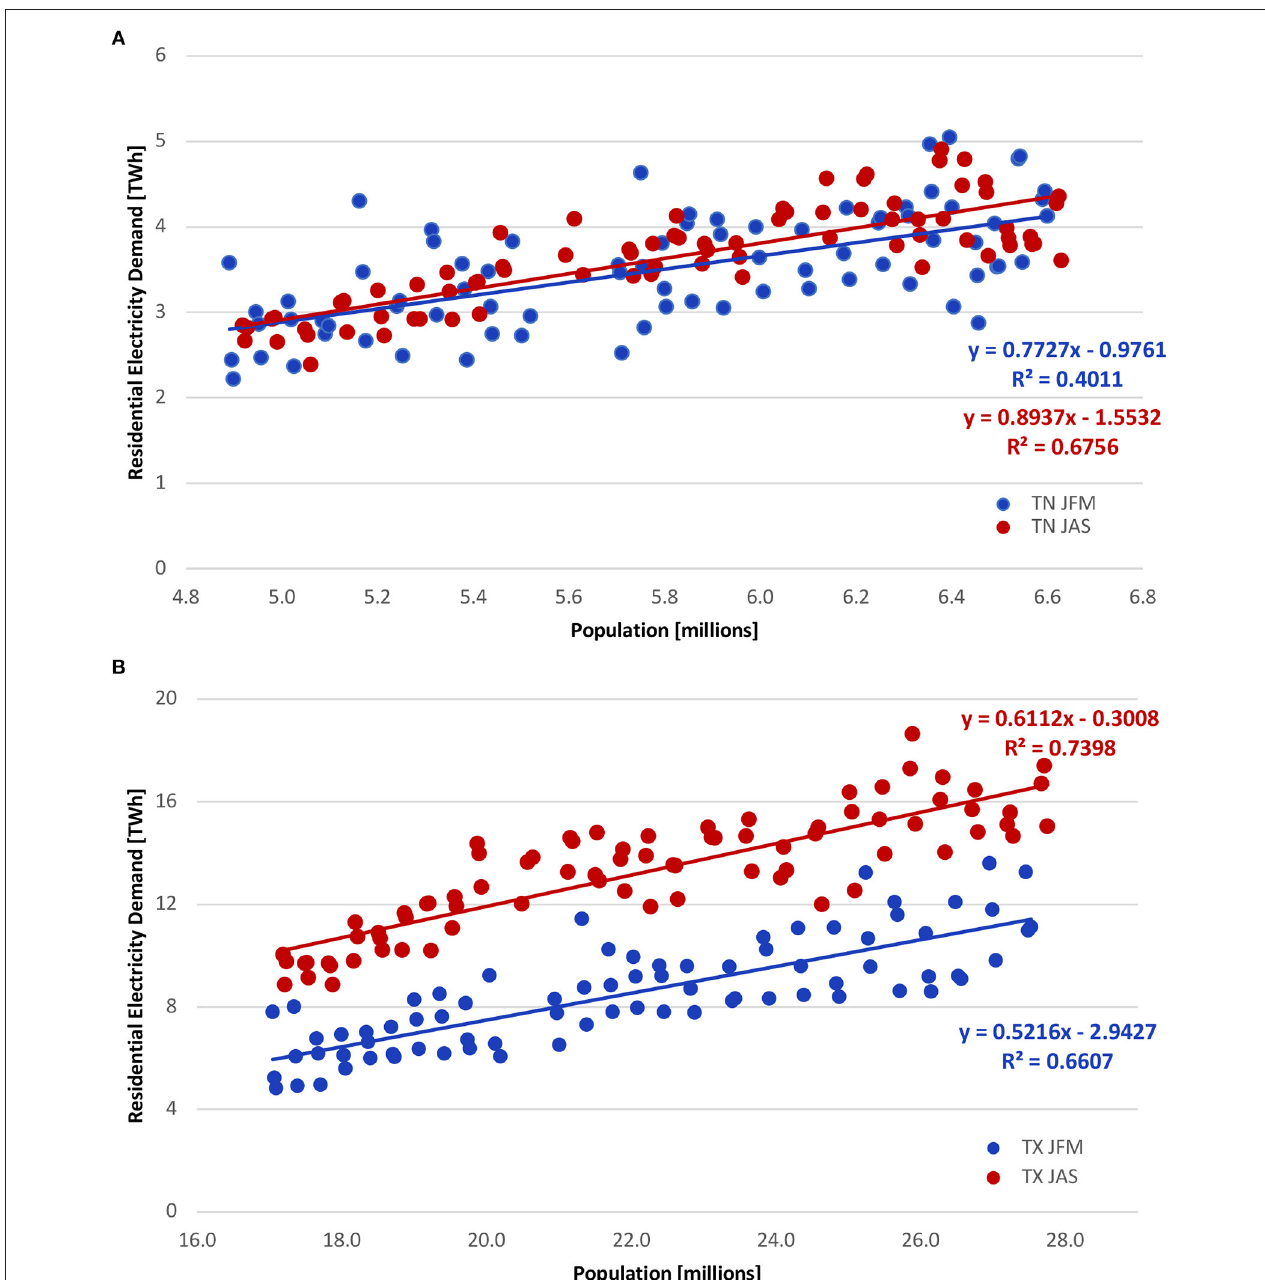
FIGURE 2 | Scatterplot of population from 1990 to 2015 in millions and the observed electricity demand (TWh) for the (A) Tennessee and (B) Texas power systems. Winter JFM (summer JAS) months are represented in blue (red) circles with the trend line (blue or red) for each season indicating the explained variability on the electricity